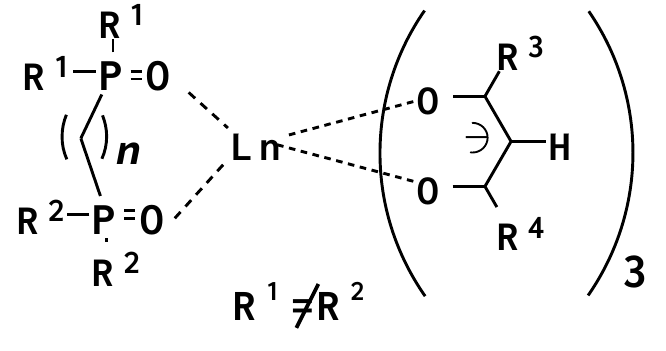
Figure 2. The second concept for the molecular design of novel rare-earth complex with non-symmetric bis-phosphine